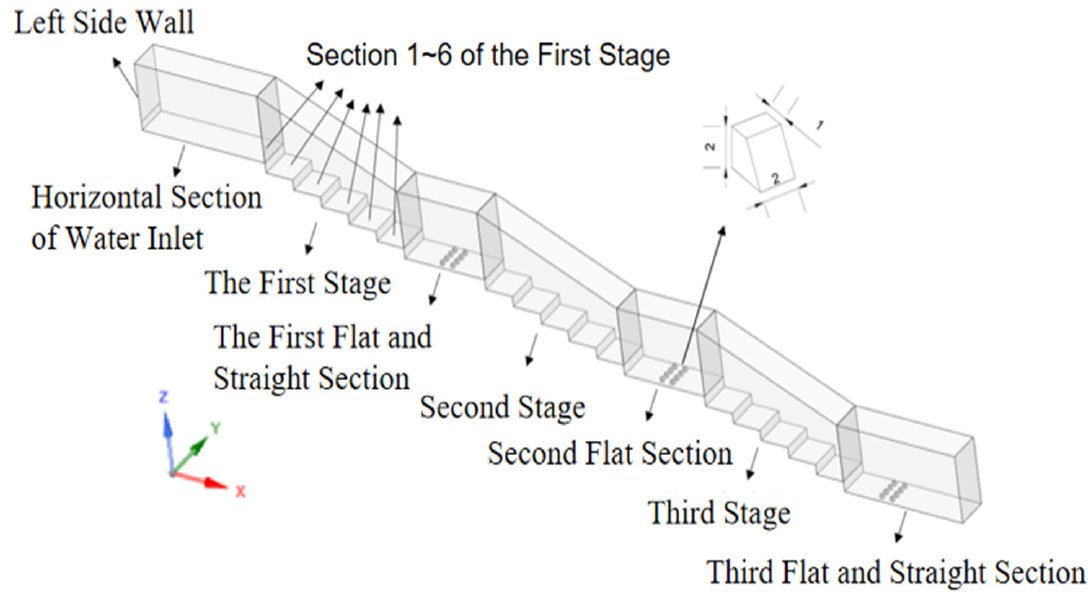
Figure 1. Schematic diagram of the numerical model. The trapezoidal energy dissipation piers are arranged in 2 rows, themselves compris- ing 8 rows, at a position of 22.5 cm in the X-axis direction of each straight section. We used three different pier arrangements for our study purposes: (1) a double-row arrangement (two rows of dissipative piers in alignment); (2) a staggered arrangement (a staggered placement of two rows of piers); and (3) a control/traditional arrangement (no piers). The longitudinal position is 2.4 cm from the side wall, and the longitudinal spacing of the piers is also 2.4 cm. In the staggered arrangement, the first row of the piers is shifted by 1 cm as a whole, and the second row is moved to the right by 1 cm, as shown in Figure 2. Six different flow values were selected, as shown in Table